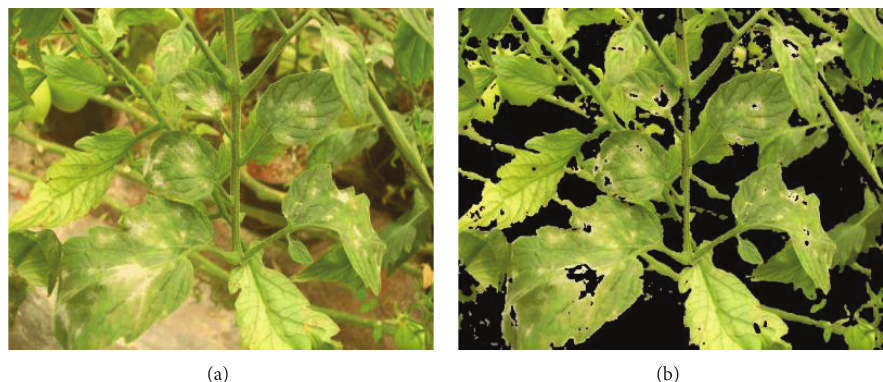
Figure 5: (a) Original image and (b) same image after applying Bayesian classifier.